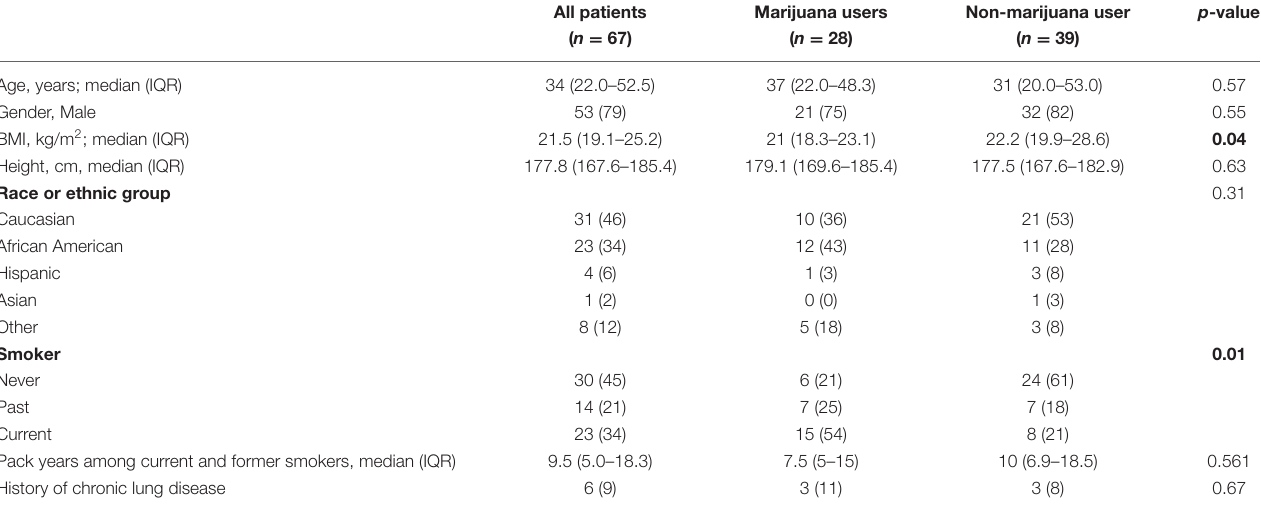
TABLE 1 | Patient characteristics.